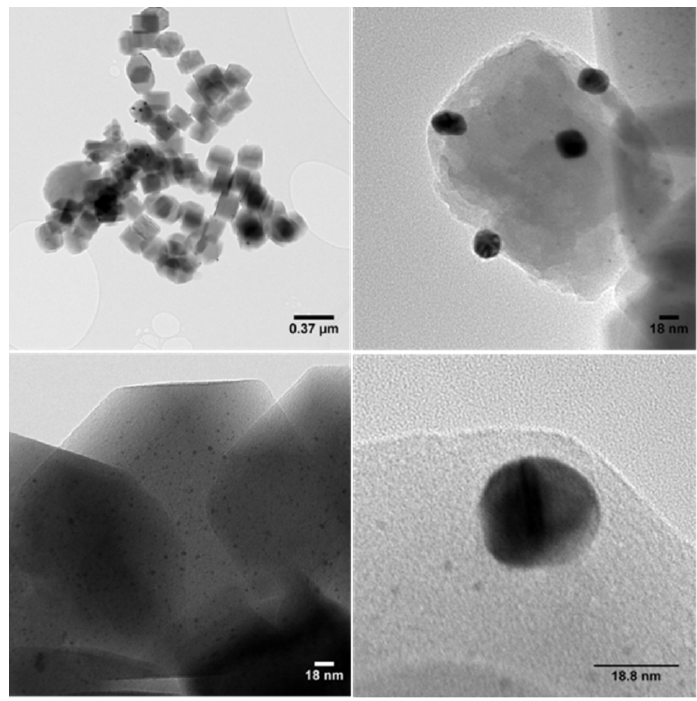
Figure 4. TEM images of fresh ( top ) and spent ( bottom ) 1 wt% Cu-MOR catalysts.